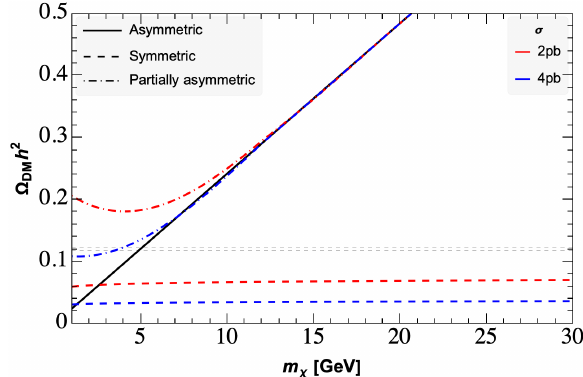
Figure 5 . Relic abundance as the function of DM mass for asymmetric (solid), symmetric (dashed) and partially-asymmetric (dot-dashed) cases. The red and blue curves correspond to two different choices of σ = 2 pb , 4 pb respectively. The asymmetric case is linearly dependent on mass and η , i which is chosen to be equal to η . The symmetric case is almost independent of mass and depends B only on the values of σ . The partially-asymmetric case becomes independent of σ i values, e.g., it starts exhibiting a completely asymmetric